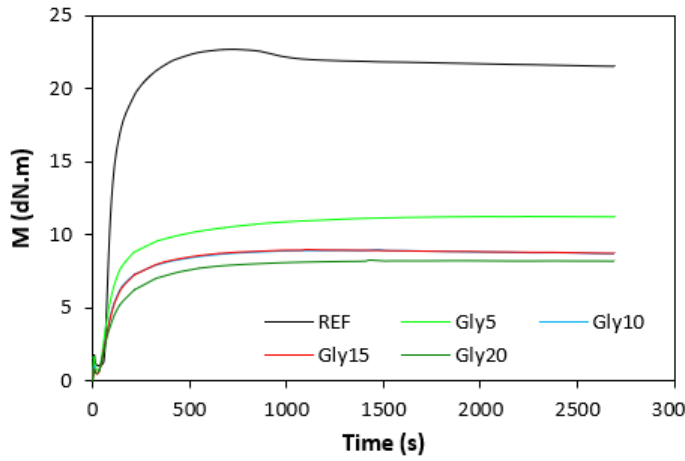
Figure 2. Vulcanization curves of rubber compounds NBR/CB-L30.